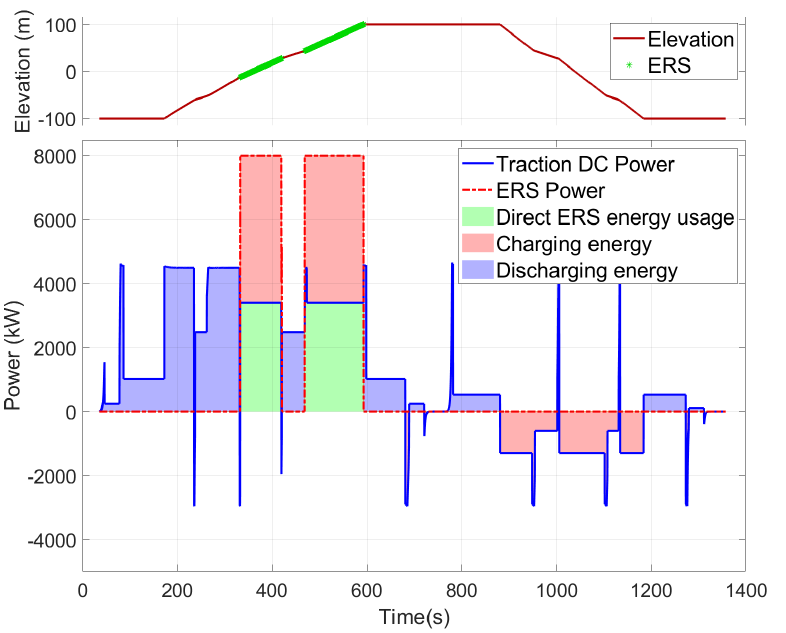
Figure 9. Power from the ERS (dash-doted red) and power to the motors (blue) for the Short 2 drive cycle with the “Battery + ERS” drivetrain. Elevation and ERS placement shown for